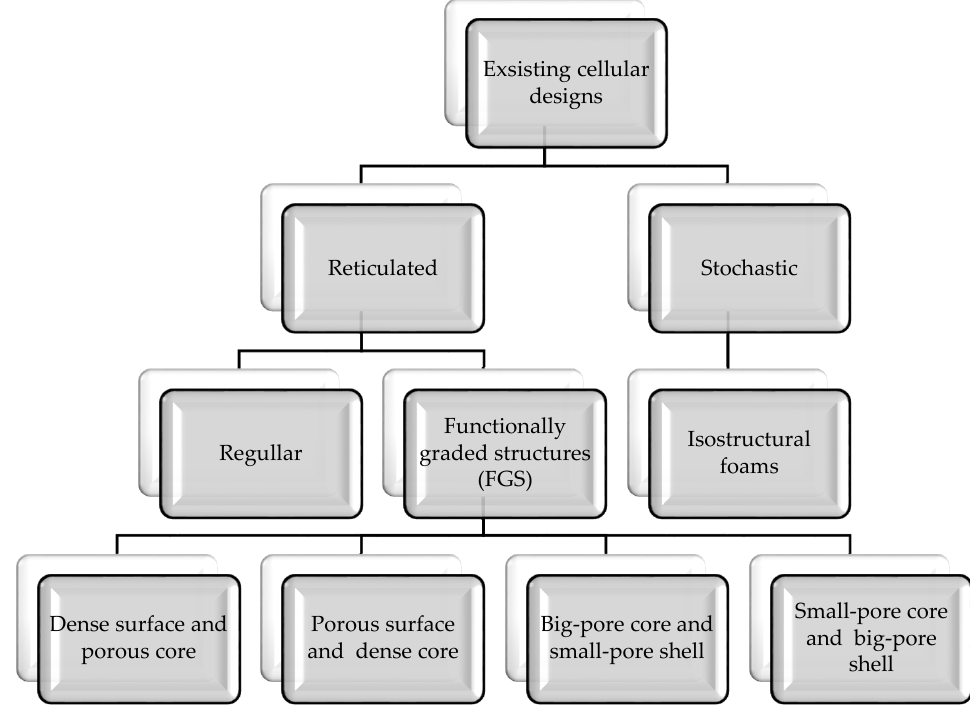
Figure 2. Collection of existing cellular